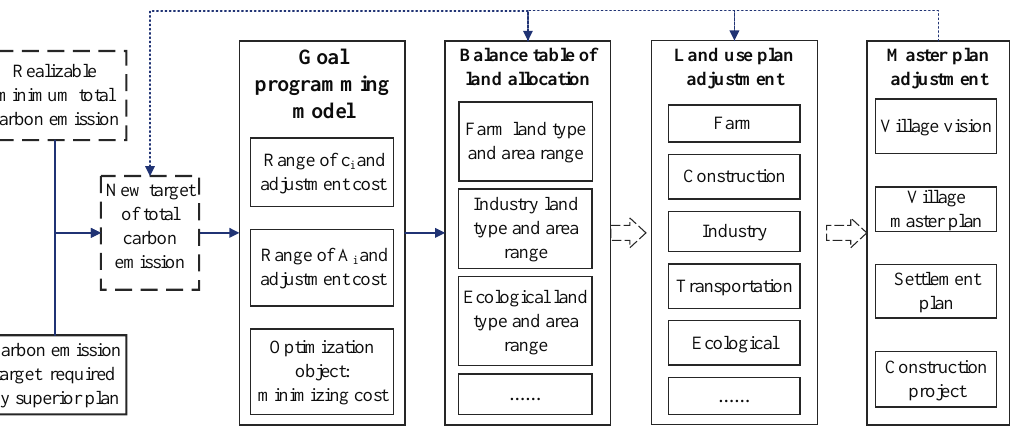
Figure 3. Goal programming-based optimization of land-use structure.